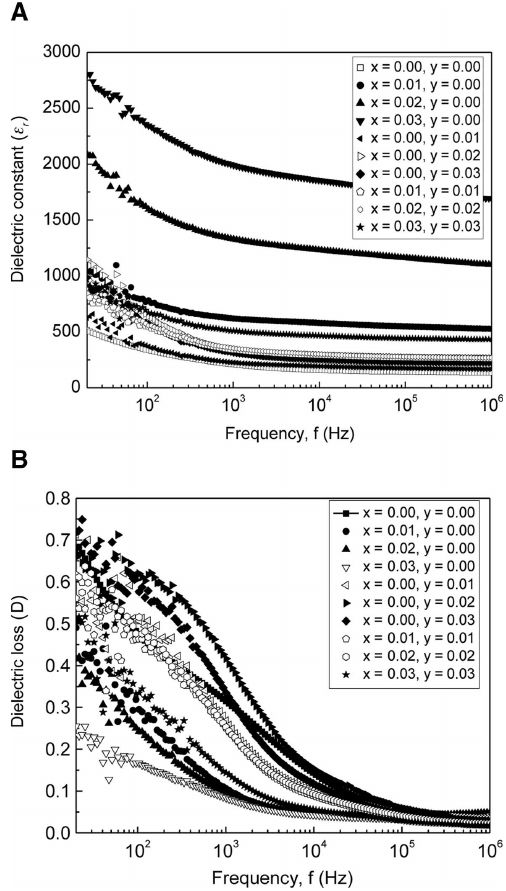
Figure 7: Variation of the (A) dielectric constant and (B) dielectric loss as a function of